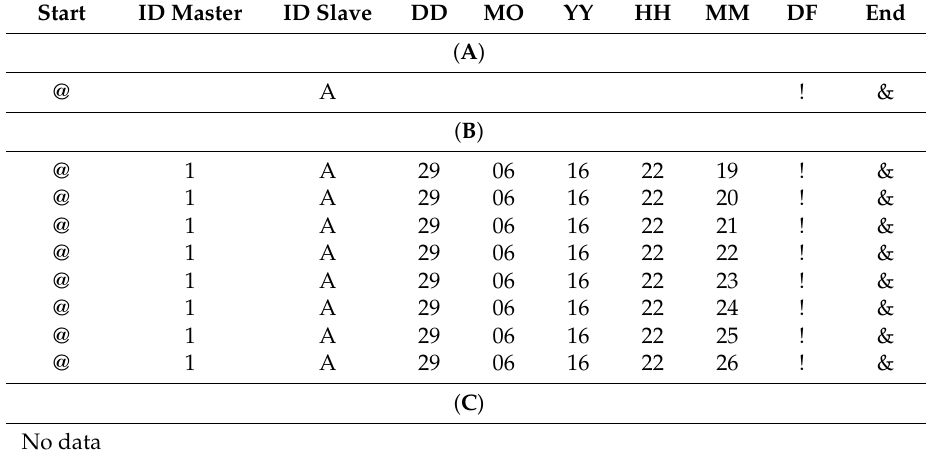
Table 2. Monitoring data frame. ( A ) Master 1. Missing people; ( B ) Master 1. Found people; ( C )